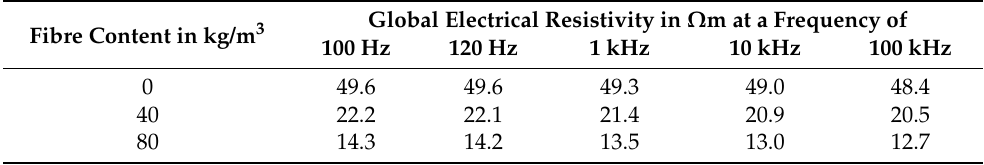
Table A43. Results of the resistivity measurements of the concrete mixture 32-60-300-00 after storage in Ca(OH) 2 for 28 days for the investigations of possible leaching